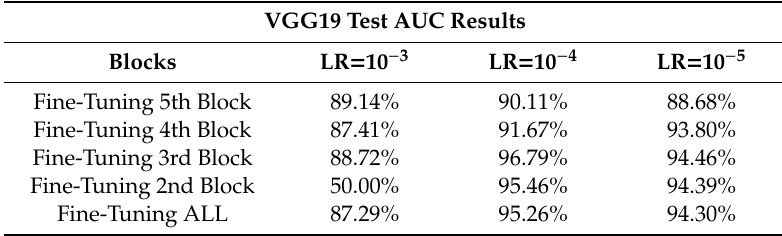
Table 7. Results of the VGG19 architecture using the BreakHis dataset.